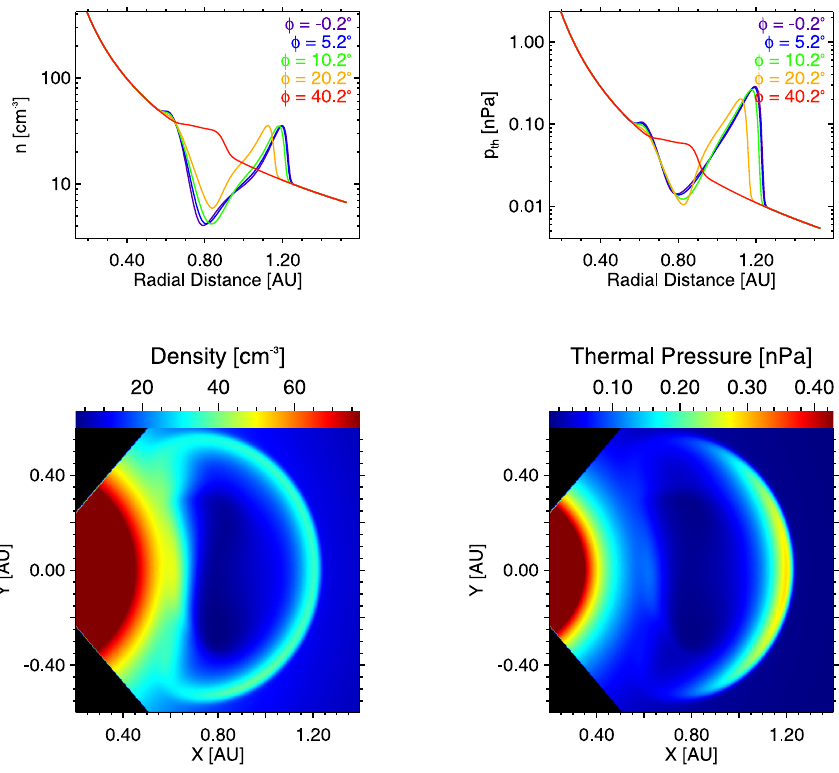
Fig. 3. Density (left) and thermal pressure (right) for the H − e magnetic cloud near Earth. Results obtained after ∼ 63 h of MC propagation are pre- sented for the distributions of velocity and the magnetic